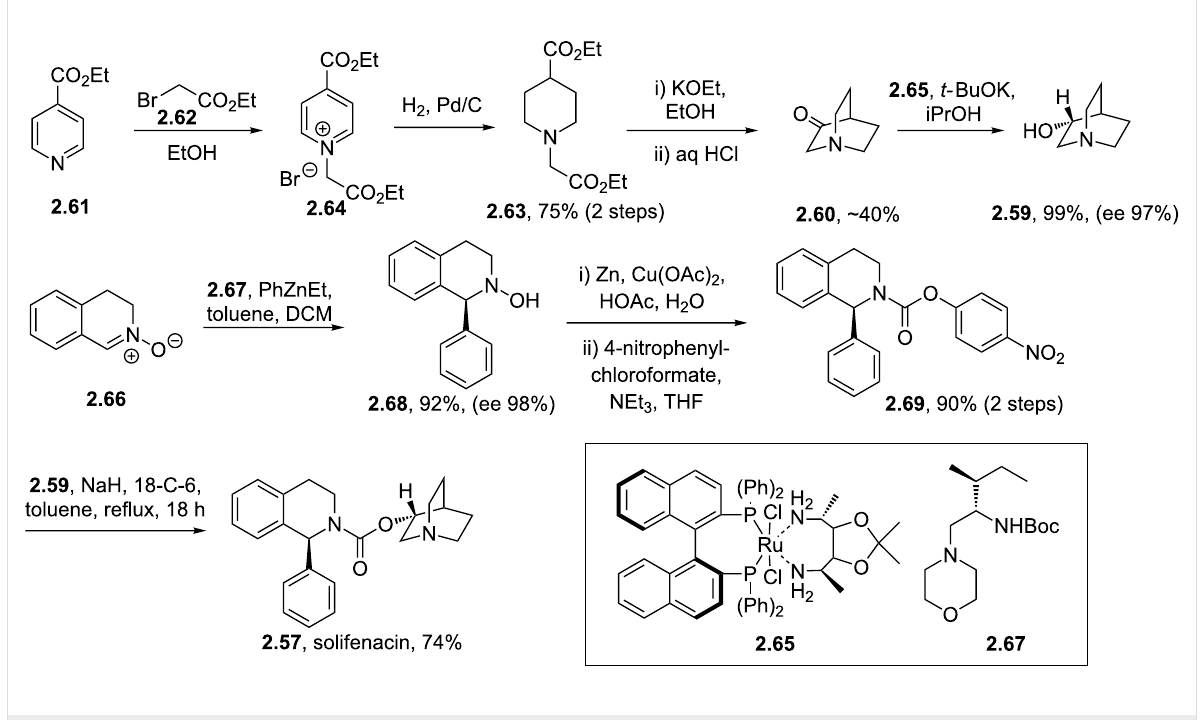
Scheme 28: Enantioselective synthesis of solifenacin.